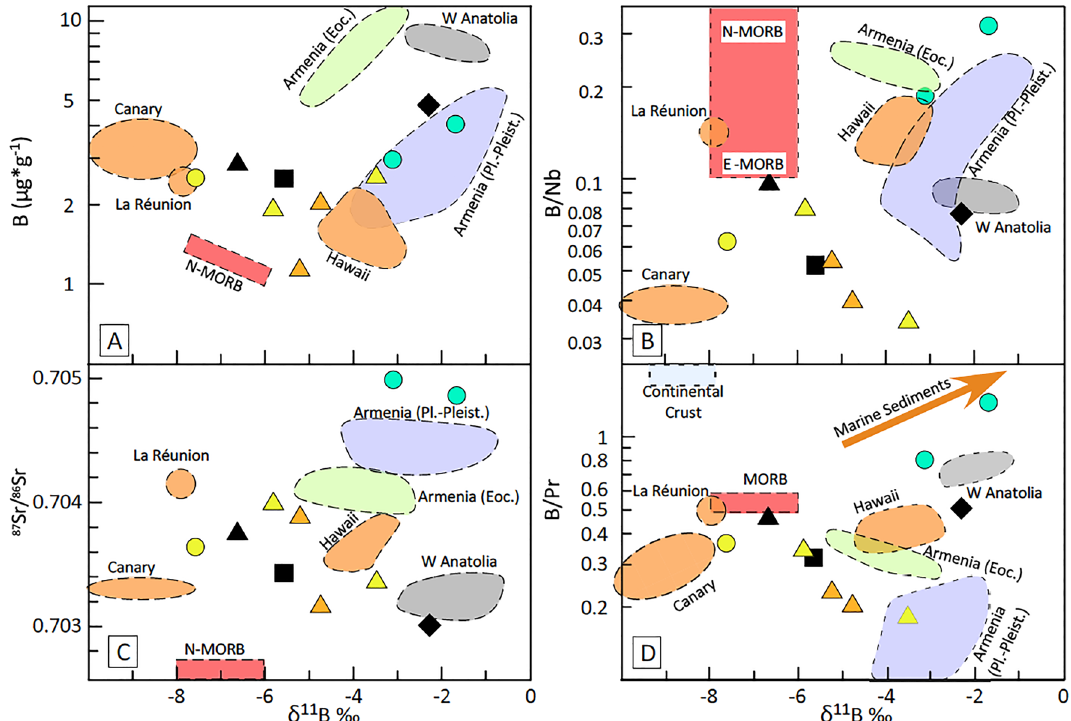
Figure 4. Boron isotopes ratios of studied rocks with respect to some continental and oceanic basalts. ( A ) δ 11 B vs. B contents; ( B ) δ 11 B vs. B/Nb; ( C ) δ 11 B vs. 87 Sr/ 86 Sr; ( D ) δ 11 B vs. B/Pr. Variation field of MORBs 32 , OIBs 33 and collision-related Armenian rocks 35 are also shown for comparative purposes. Symbols as in Fig.